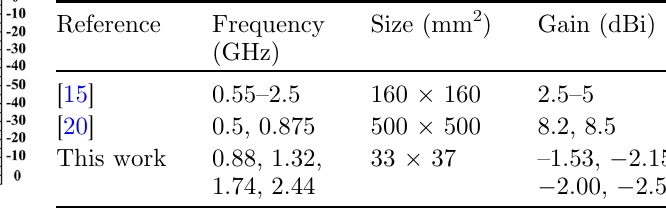
Table 1. Comparison between ours and others ’